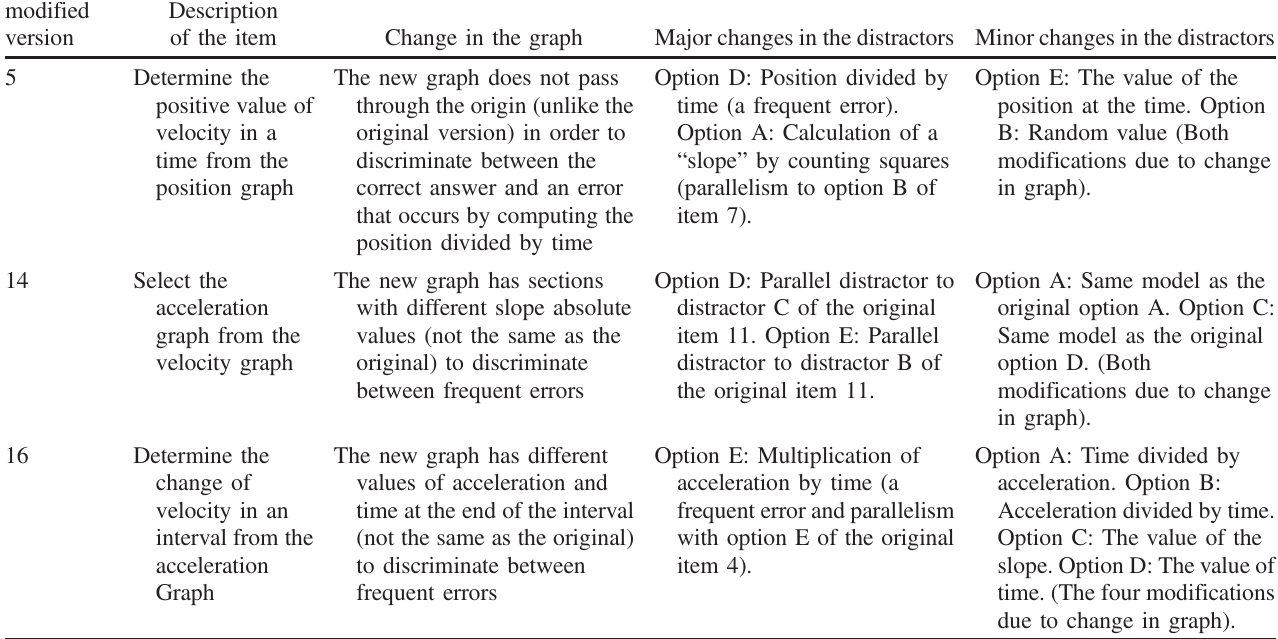
TABLE VII. Description of the modifications and the reasons behind these modifications to the items with changes in the graph of the statement and major and minor changes in the distractors (items 5, 14, and 16; see Table III). Note that in this group of items five major changes in the distractors were made.